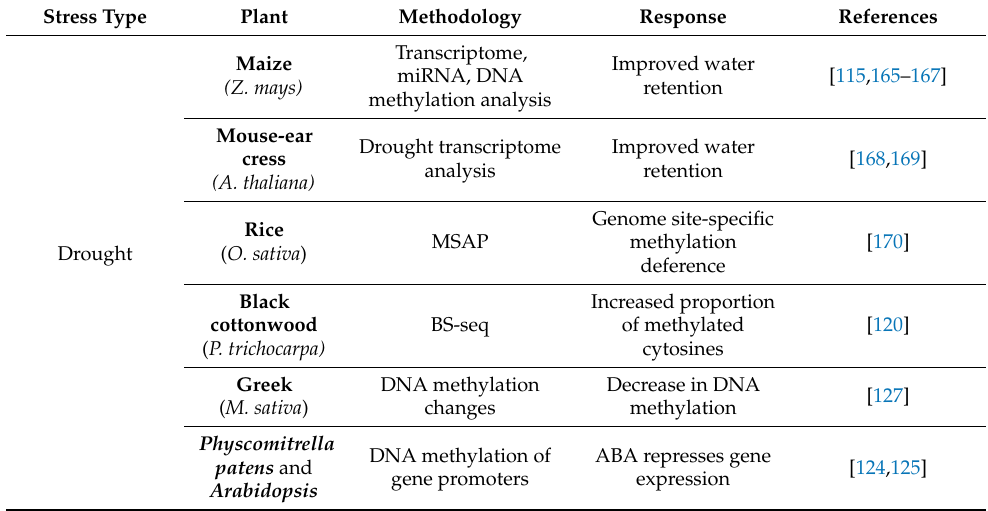
Figure 1. Schematic representation of regulatory network governing epigenetic modifications in response to abiotic stresses and during development in plants. The epigenetic modifications are shown here, at two levels: DNA methylation and RNA biogenesis. The boxes colors are displaying symmetry in explanations, epigenetic type, process and players involved during epigenetic modifications. The plasticity during development and abiotic stress management is displayed via routes of RNA biogenesis and DNA methylation, RNA biogenesis generating miRNAs = MicroRNAs, siRNAs = small interfering RNAs, PTGS = posttranscriptional gene silencing, TGS = transcriptional gene silencing, 24nt siRNAs = 24nucleotide small interfering RNAs, RdDM = RNA-directed DNA methylation, AGO = argonaut, CG, CHG, CHH = cytosine guanosine (where H is any base except G), MET1 = methyl transferase 1, CMT3 = chromomethylase 3, DNMTs = DNA methyltransferases, DRM2 = domains rearranged methylase. Table 1. Recent studies on DNA methylation in diverse plant species under drought, salt, and heavy metals